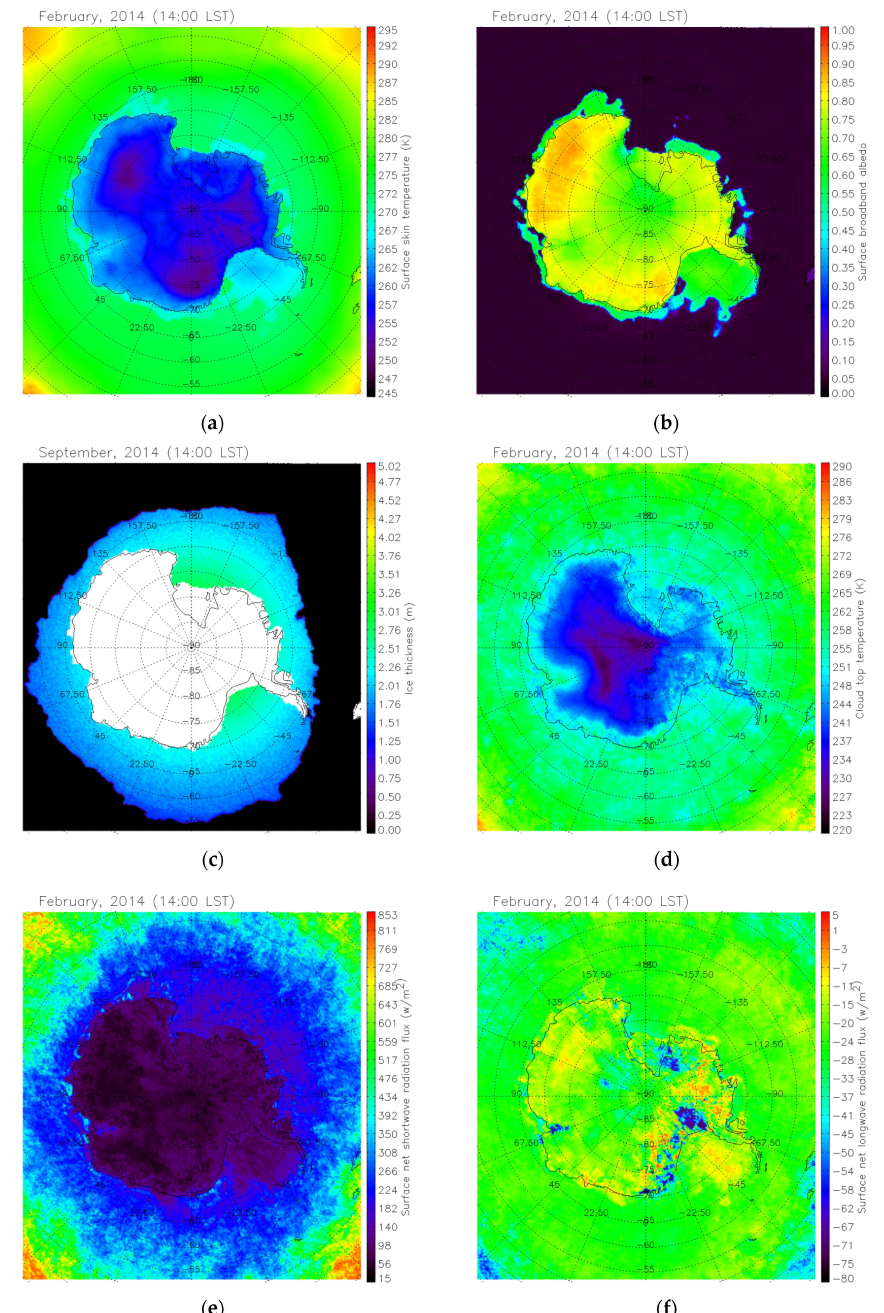
Figure 6. Examples of some APP-x variables over the Antarctic. Monthly means are for February 2014 except for sea ice thickness, which is for September 2014. Shown are surface skin temperature ( a ), surface broadband albedo ( b ), sea ice thickness ( c ), cloud top temperature ( d ), surface net shortwave radiative flux ( e ), and surface net longwave radiative flux ( f